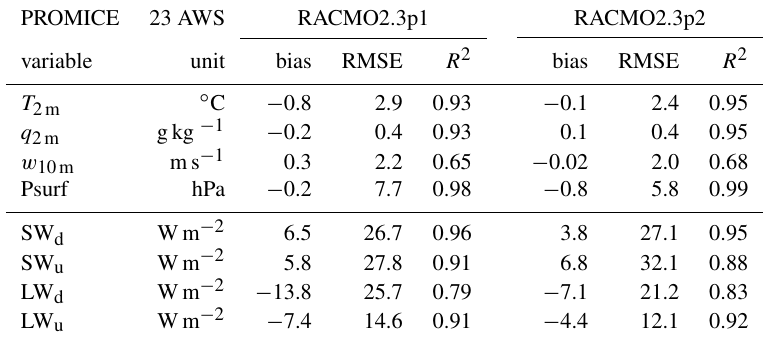
Table 1. Difference between daily modelled RACMO2.3p1 (2004–2015) or RACMO2.3p2 (2004–2016) and observed meteorological data and SEB components collected at 23 PROMICE AWSs (green dots in Fig. 1). Statistics include model bias (RACMO2.3pX – observations), RMSE of the bias as well as the determination coefficient of daily mean data. All fluxes are set to positive.